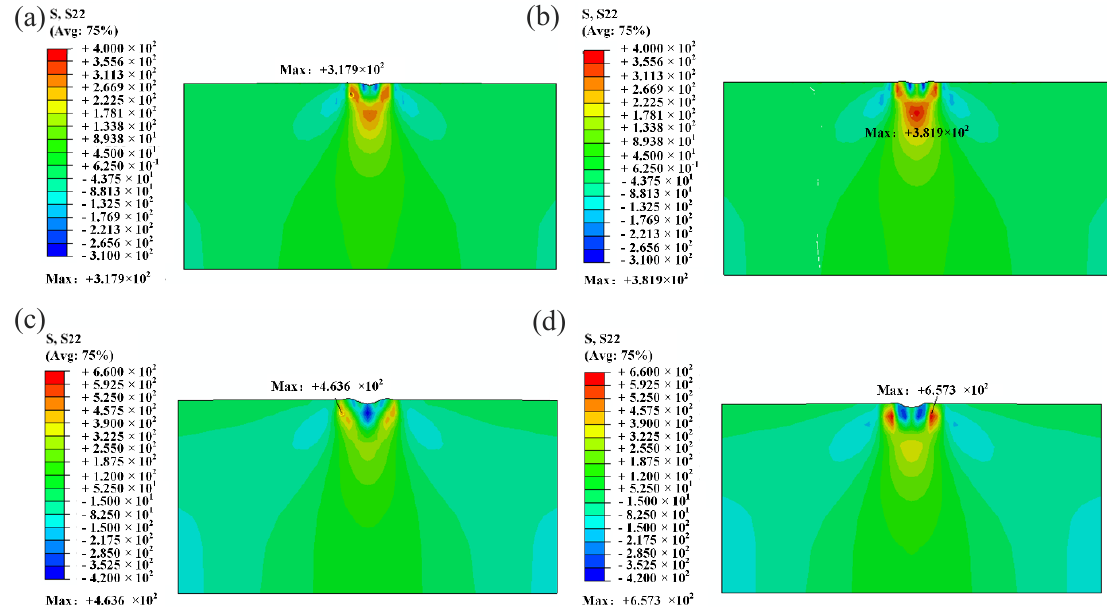
Figure 11. Cross-sectional stress field after unloading under different scratch directions. ( a ) cross-section at Z = 40 um under edge-forward; ( b ) cross-section at Z = 40 um under face-forward; ( c ) cross-section at Z = 60 um under edge-forward; ( d ) cross-section at Z = 60 um under face-forward.